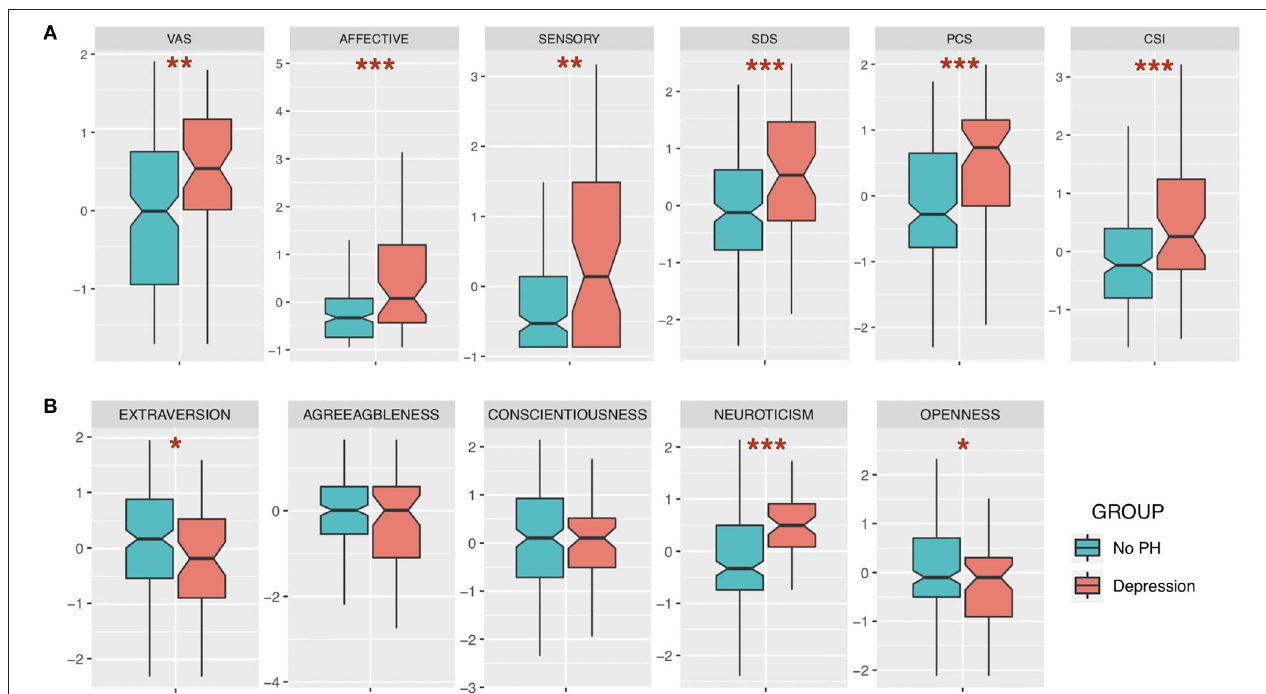
FIGURE 1 | Comparisons between groups of burning mouth syndrome (BMS) patients with depression history and without psychiatric history (standardized). (A) Clinical measures of pain, pain characteristics, depressive state, catastrophizing, and central sensitization. (B) Big five traits. VAS, Visual Analog Scale; SDS, Self-Rating Depression Scale; PCS, Pain-related Catastrophizing Scale; CSI, Central Sensitization Inventory. Wilcoxon rank sum test; * p < 0.05; ** p < 0.01; *** p < 0.001.